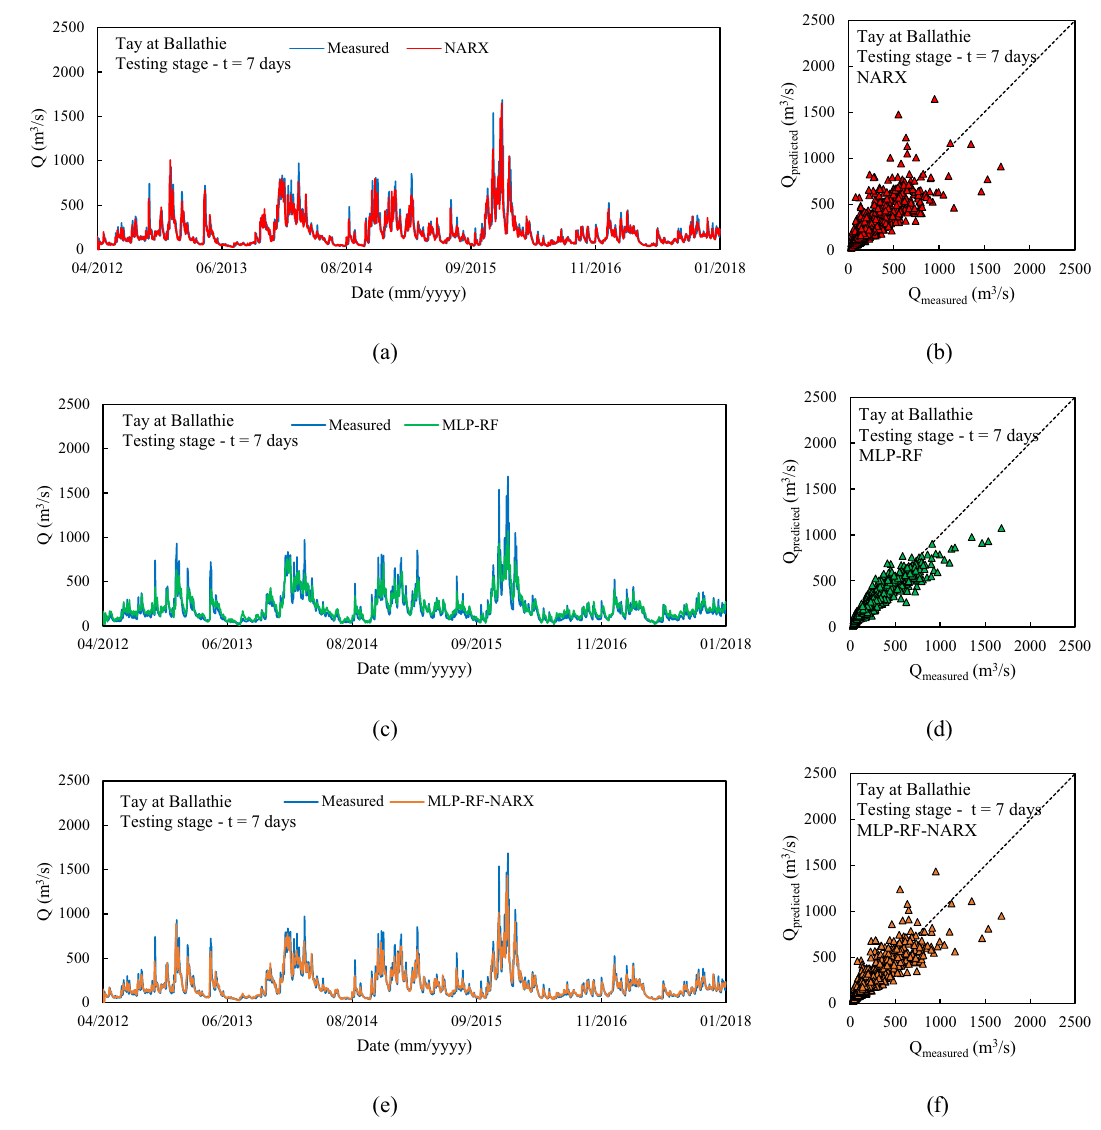
Figure 8. 7-days ahead predictions for Tay at Ballathie: NARX ( a , b ); MLP-RF ( c , d ); MLP-RF-NARX ( e , f